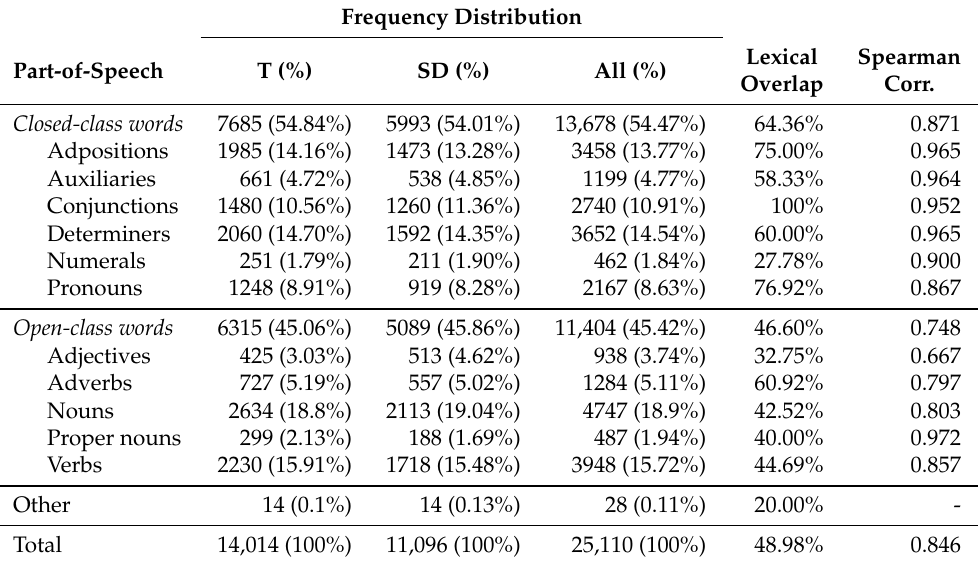
Table 3. Frequency distribution as count and relative frequency over the corresponding corpus (%) of lemmas based on their grammatical category in the Truth (T), Simulated Deception (SD) sub-corpora and in the full corpus of testimonies (All). The lexical overlap refers to the rate of unique lemmas shared by T and SD testimonies. Spearman correlations, computed for each POS between the frequency rankings of words shared by T and SD, are all significant ( p <